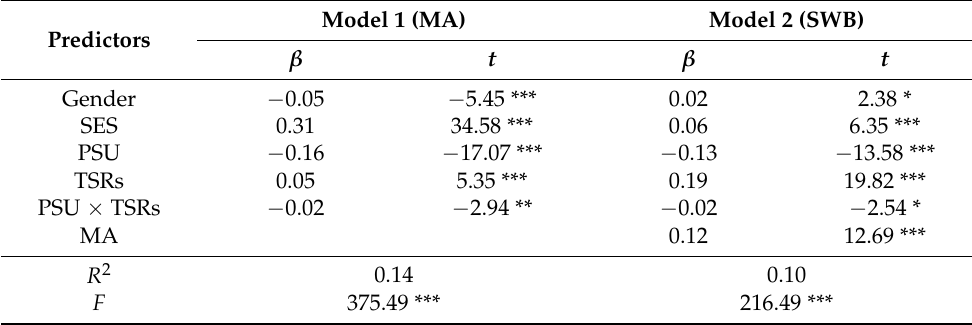
Table 3. Standardized coefficients for moderated mediation effect model.